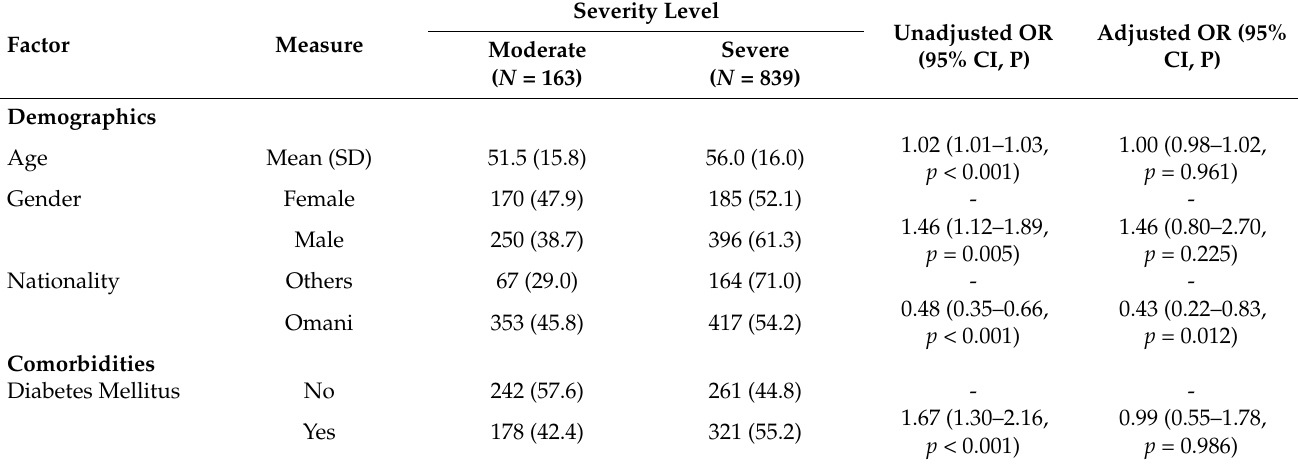
Table 3. Demographic, clinical, laboratory and therapeutic determinants of COVID-19 severity among hospitalized